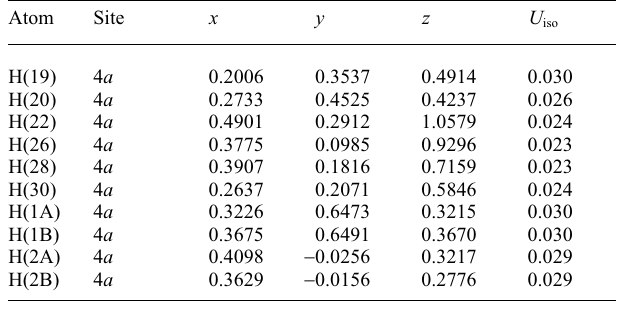
Table 3. Atomic coordinates and displacement parameters (in Å 2